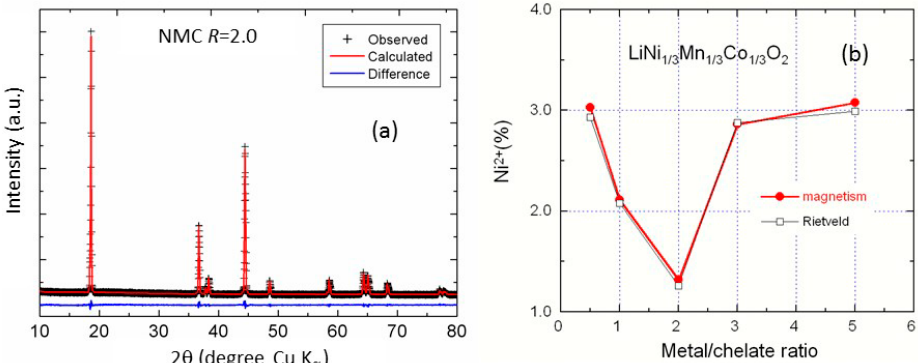
Figure 12. ( a ) Rietveld refinement patterns of NMC synthesized at R = 2 via wet chemical method ( R p = 9.8%). The plus marks show observed X-ray diffraction intensities and the solid line (in red on the web version) represents calculated intensities. The curve at the bottom (in blue on the web version) is the difference between the calculated and observed intensities on the same scale; ( b ) The concentration of Ni(3 b ) defects (site-exchange rate of the Li + /Ni 2+ cation mixing) as a function of the R parameter for the symmetric NMC compounds.